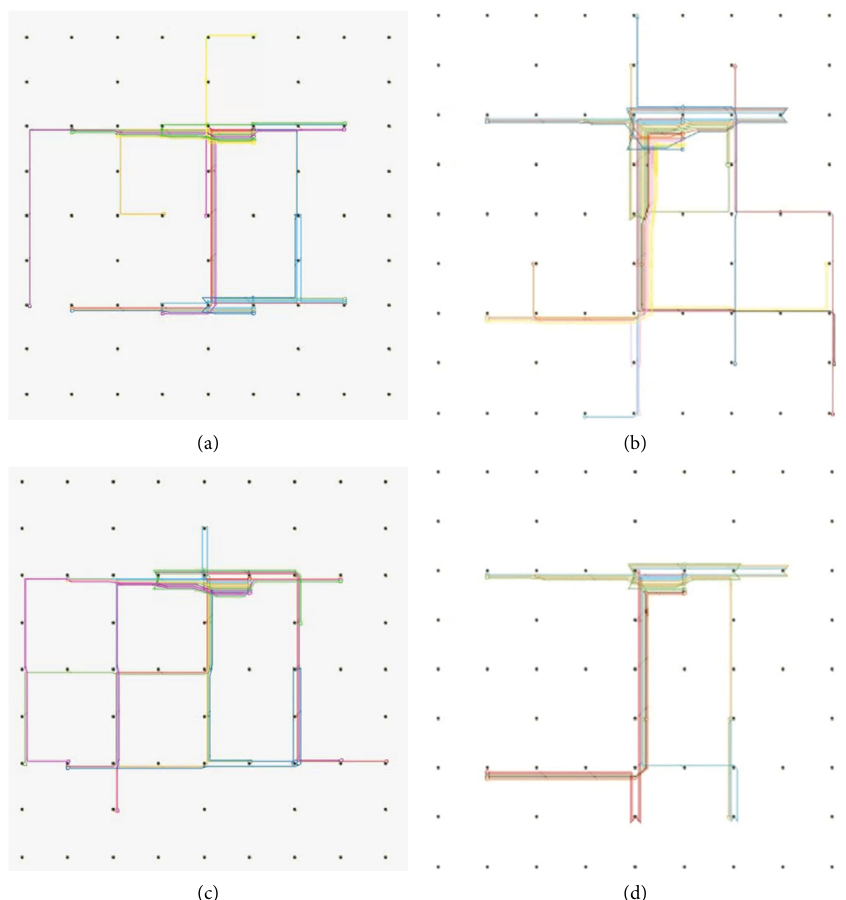
Figure 10: Optimal transit network: (a) Best system efficiency (with equity). (b) Best system efficiency (without equity). (c) Best unmet demand (with equity). (d) Best unmet demand (without